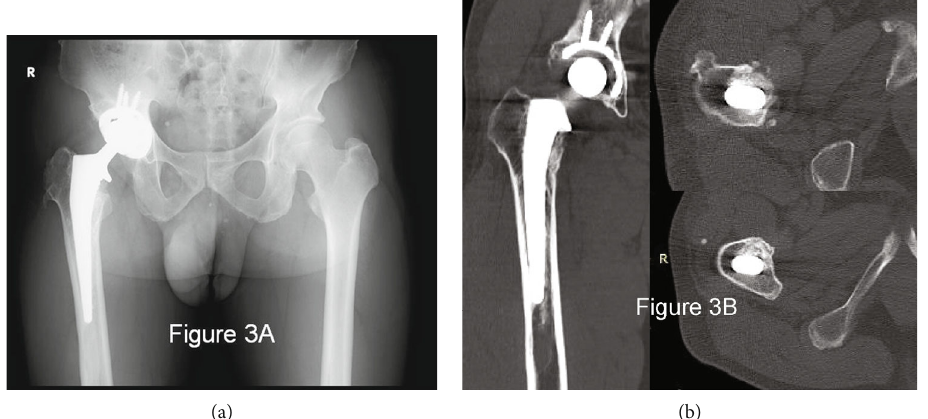
Figure 3: (a) 2-year postoperative X-ray shows minute subsidence and homogenized allograft on the calcar. (b) CT at 2 years proves rigid fi xation in Gruen zones 1, 2, and ongoing osteogeneration in other